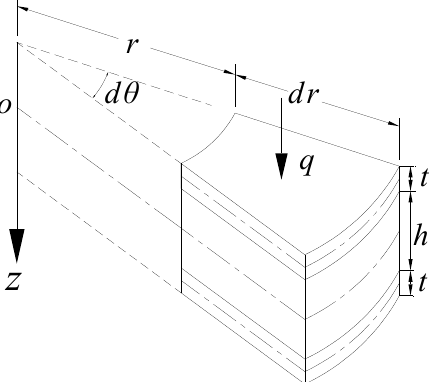
Figure 1. Coordinates and dimensions of the circular sandwich plate.